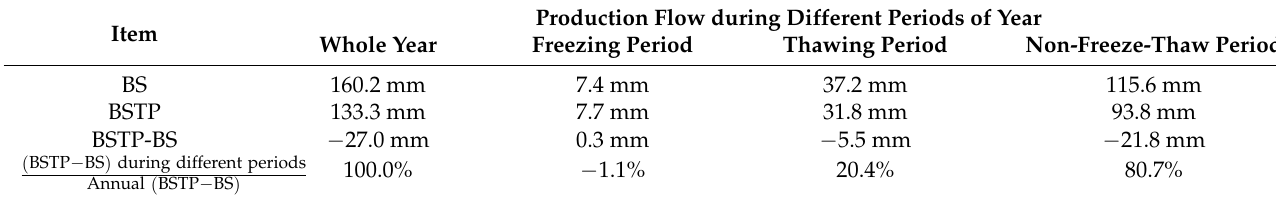
Table 8. Production flow variation during different